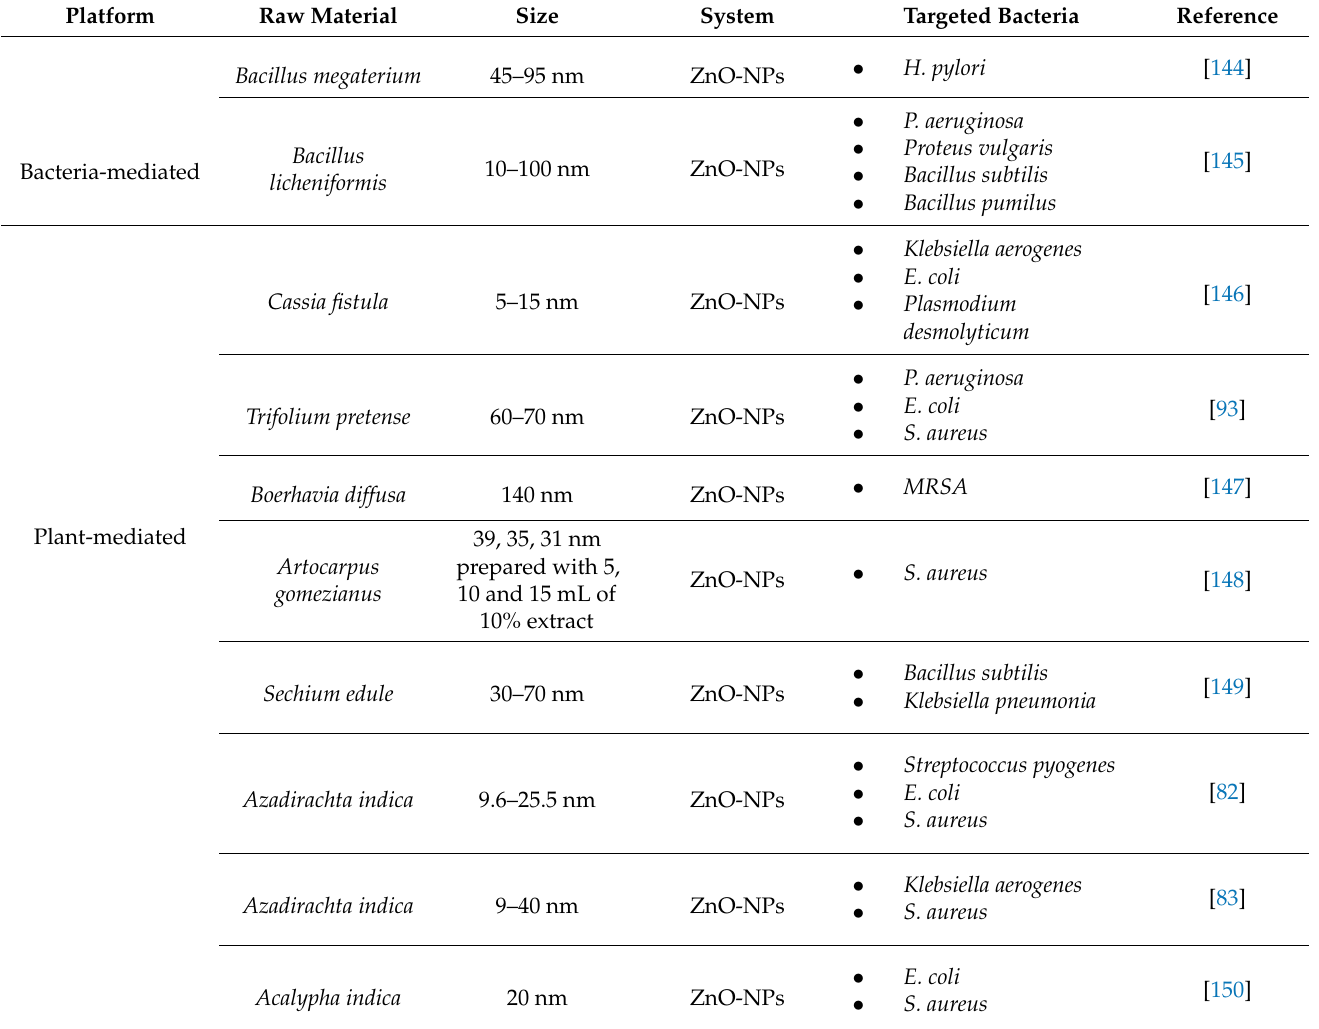
Table 6. Green-synthesized ZnO-NPs applications for antibacterial